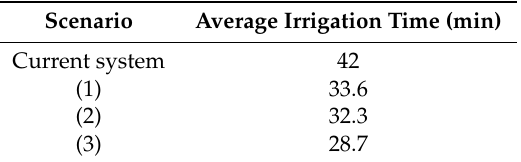
Table 4. Average irrigation time per